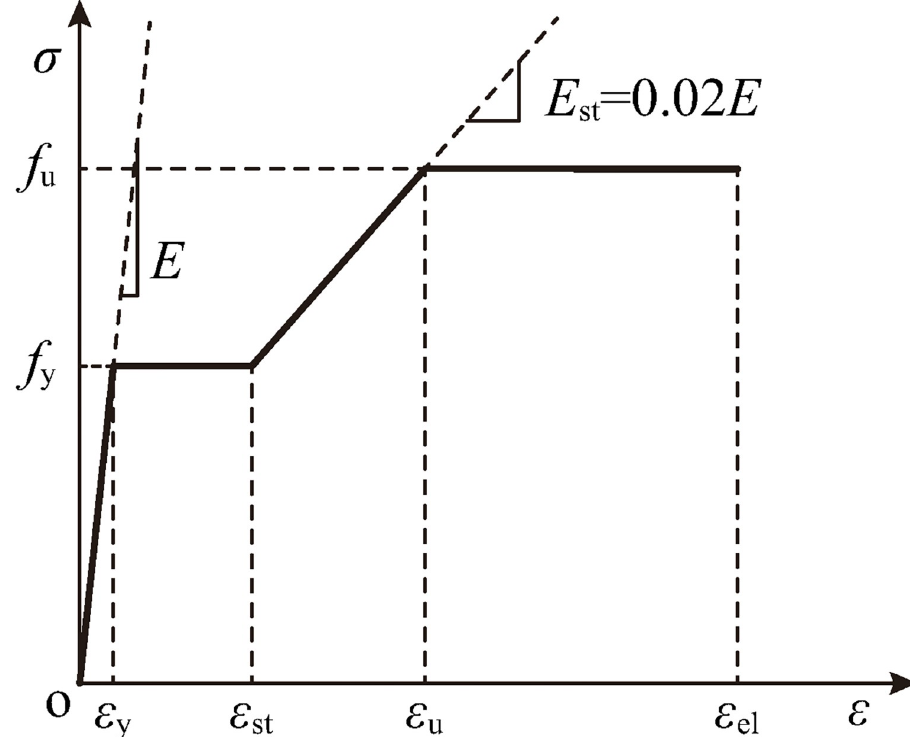
Fig 8. Constitutive relationship of